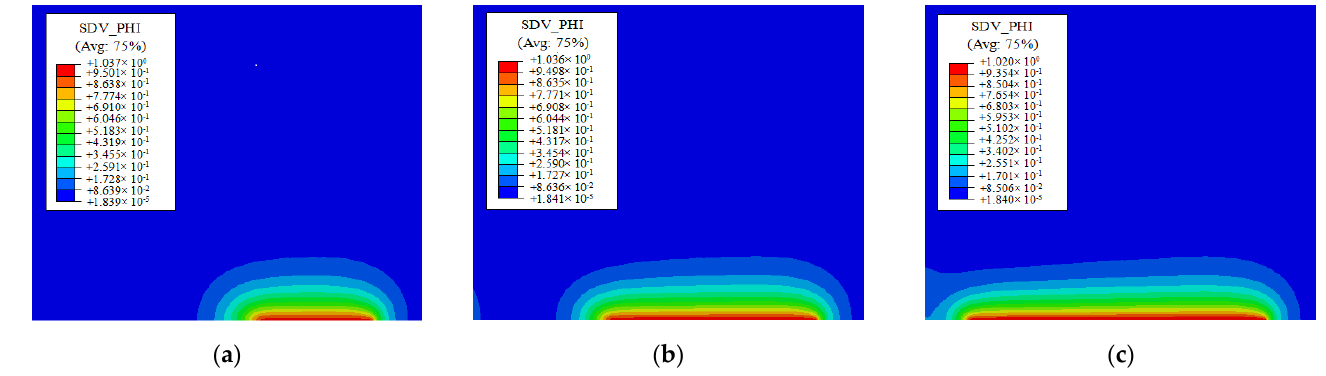
Figure 12. Distributions of crack phase-field value at crack tip after some amount of fracture prop- agation for C 0 = 7.0 ppm: ( a ) u = 0.38 mm, ( b ) u = 0.48 mm, ( c ) u = 0.80 mm.